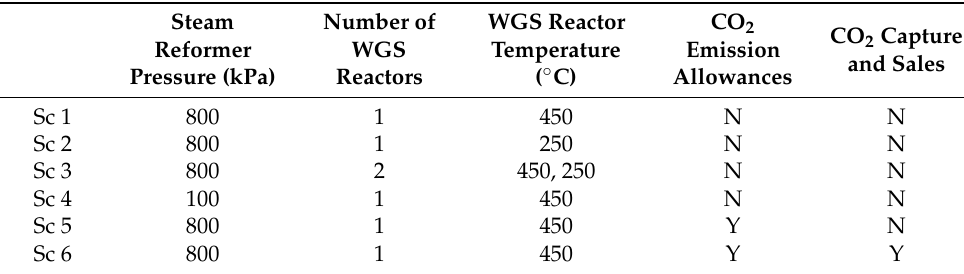
Table 2. Six scenarios of steam methane reforming process with different design and operat- ing